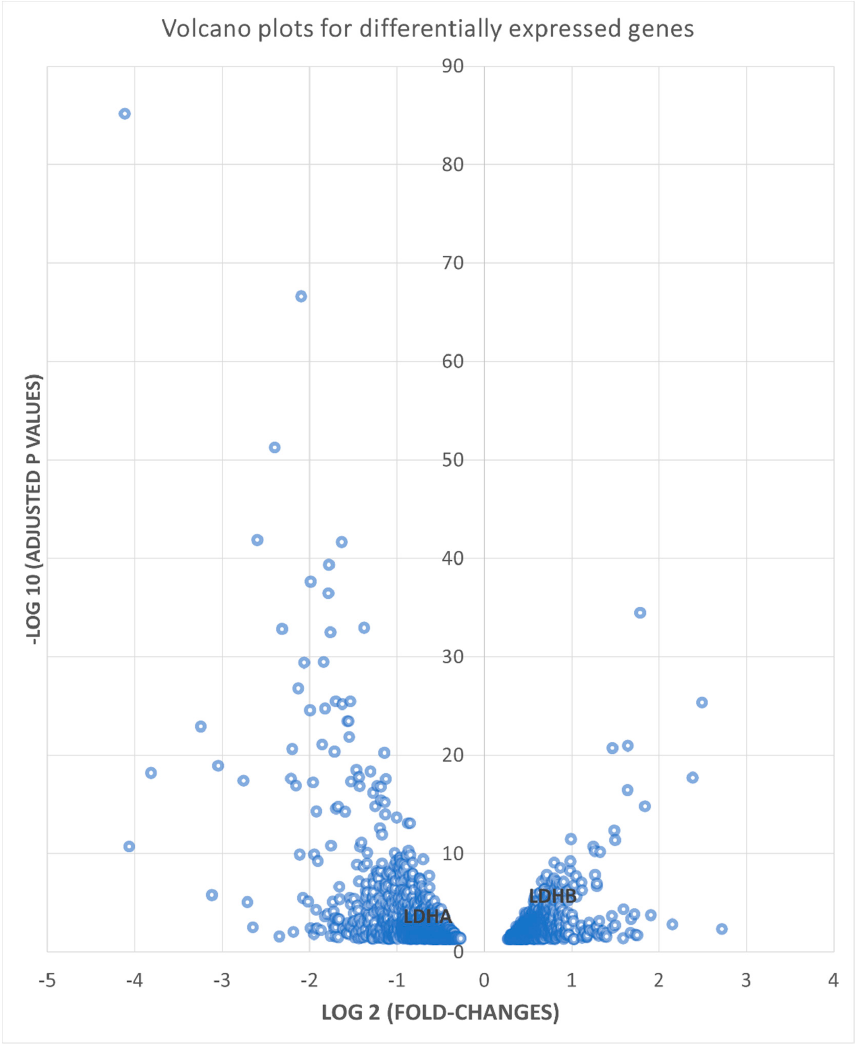
Figure 1. Volcano plots of all 2630 differentially expressed genes at p < 0.05. X-axis is the log 2 scale of fold changes and Y axis is the − log 10 scale of adjusted p-values (FDR) based on differentially expression tests. The negative fold changes represent those DEGs upregulated by hypoxia. Supplementary Table S2 shows all 2630 DEGs that include some loci of unknown Table 1. Top ten genes upregulated by hypoxia in T98G cells by lowest Bonferroni corrected p-value. Gene ID log 2 Fold Change p-Value